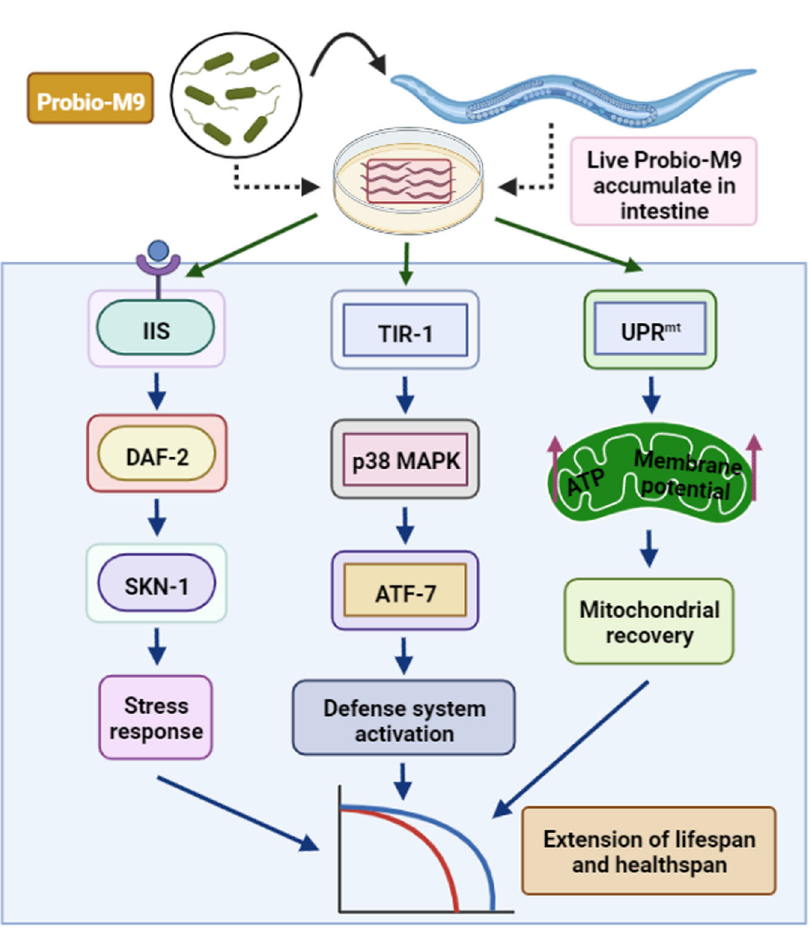
Fig. 7 Comparison of the metabolic pro fi les between OP50 and Probio-M9. PCA scores ( a ), OPLS-DA score plots ( b ) and heat map ( c ) of metabolites showed signi fi cant differences between OP50 and OP50 + Probio-M9, without overlap or crossover, with obvious separation. d Volcano plot displaying signi fi cantly metabolites between OP50 and OP50 + Probio-M9. Compared with OP50, purple dots represent metabolites that were increased with OP50 + Probio-M9 (up-regulated), blue dots represent metabolites that were decreased with OP50 + Probio-M9 (down-regulated), and red dots represent metabolites that were not changed with OP50 + Probio-M9 (insigni fi cant). e The top ten changed metabolites between OP50 and OP50 + Probio-M9. Compared with OP50, red bars represent metabolites that were up-regulated by OP50 + Probio-M9, green bars represent metabolites that were down-regulated by OP50 + Probio-M9. f KEGG enrichment analysis of metabolites that were signi fi cantly changed between OP50 and OP50 + Probio-M9 (the color of the point represents p value, and the color is the redder, the enrichment degree is the more signi fi cant; the size of the point represents the number of enriched metabolites within this pathway).